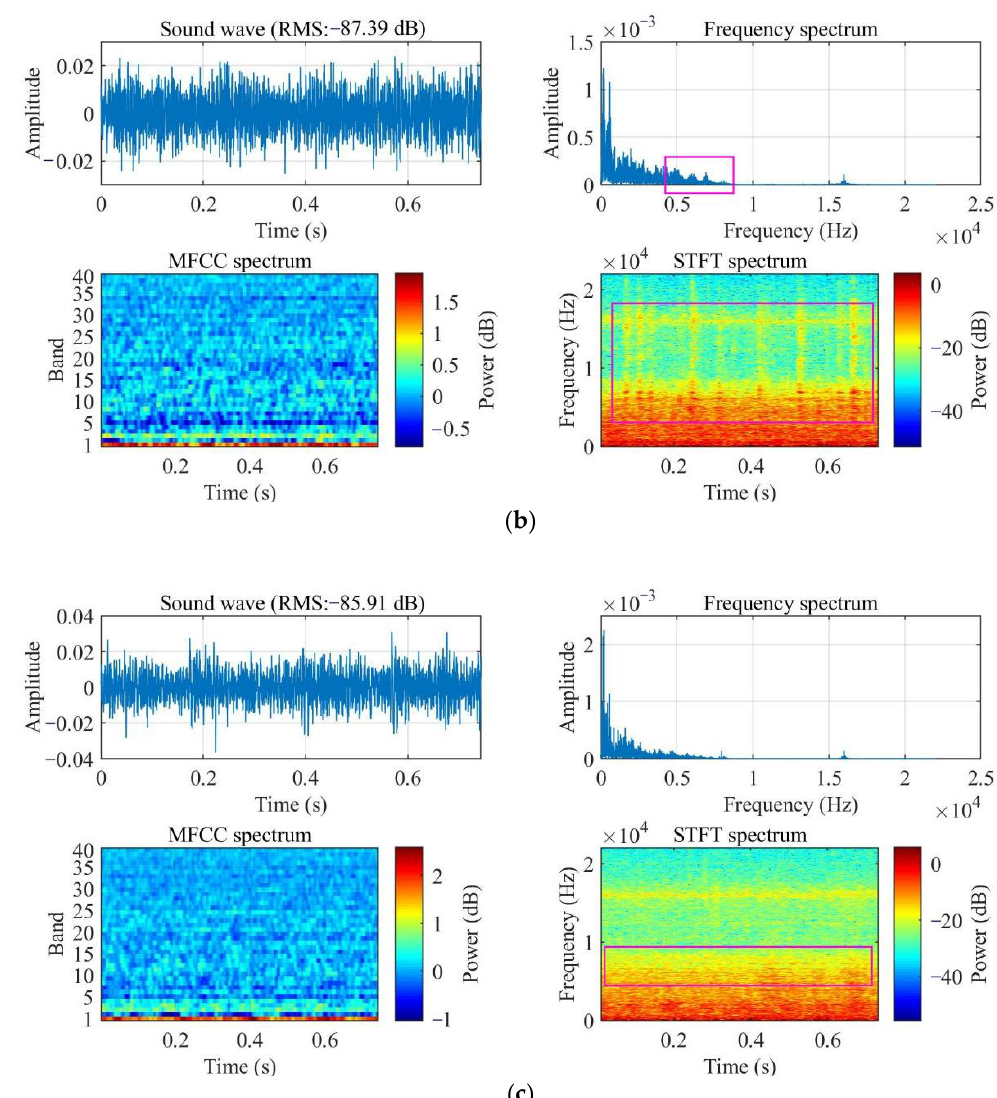
Figure 1. The time domain, frequency domain, and TFD features of the running sound of idlers in different states. ( a ) Intact state; ( b ) Bearing outer ring fault; ( c ) Idler jamming.